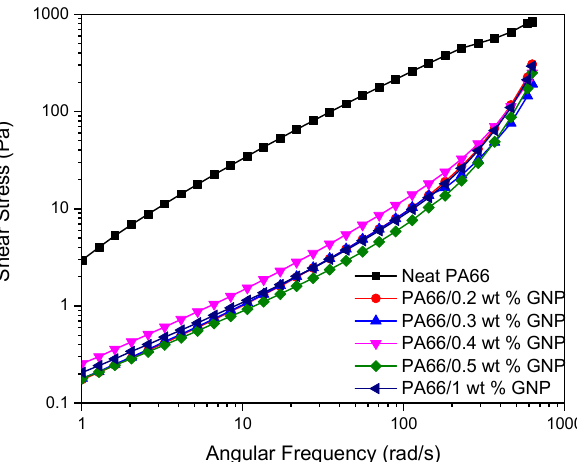
Figure 7. Change in the shear stress of PA66 and its GNP-based nanocomposites with the angular frequency.